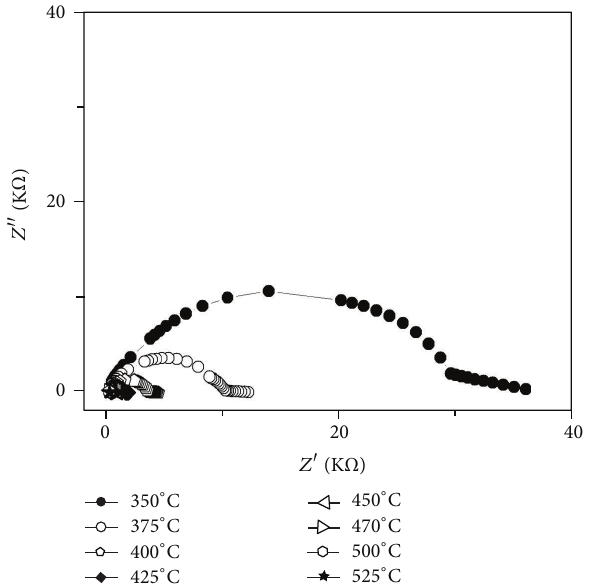
Figure 5: Plot of real part of impedance ( 𝑍 󸀠 ) with imaginary part of impedance ( 𝑍 󸀠󸀠 ) of